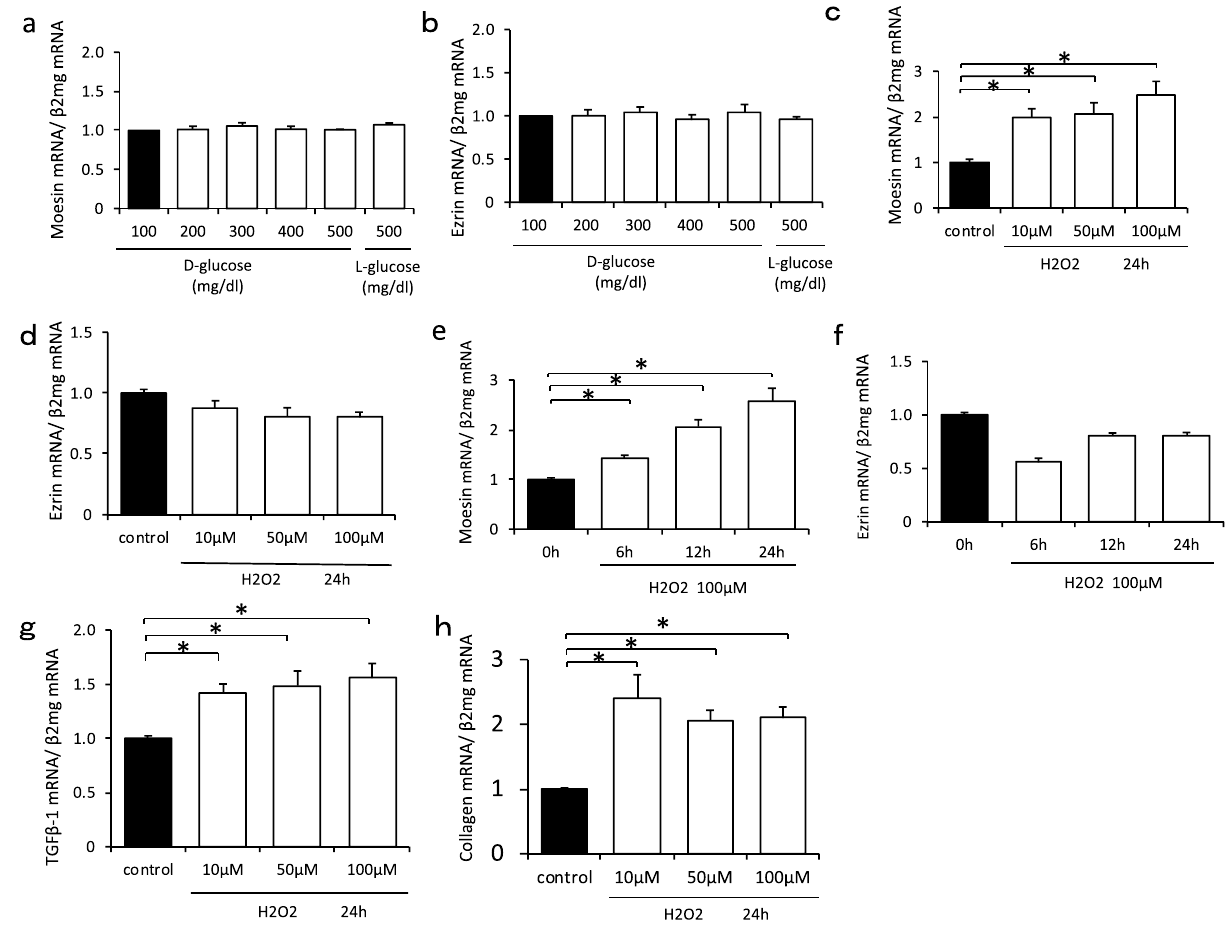
Figure 5. In vitro study for moesin expression under conditions of high glucose or oxidative stress. Moesin and ezrin mRNA expression did not change under the high glucose condition ( a , b ). Moesin mRNA expression was upregulated under hydrogen peroxide stimulation ( c ). Moesin mRNA expression increased in a time-dependent manner under the condition of 100 µM hydrogen peroxide stimulation ( e ). Ezrin mRNA expression did not change ( d , f ). The expression of Tgfb1 was enhanced under the condition of hydrogen peroxide stimulation ( g ). The expression of collagen 1 was also upregulated in the same condition ( h